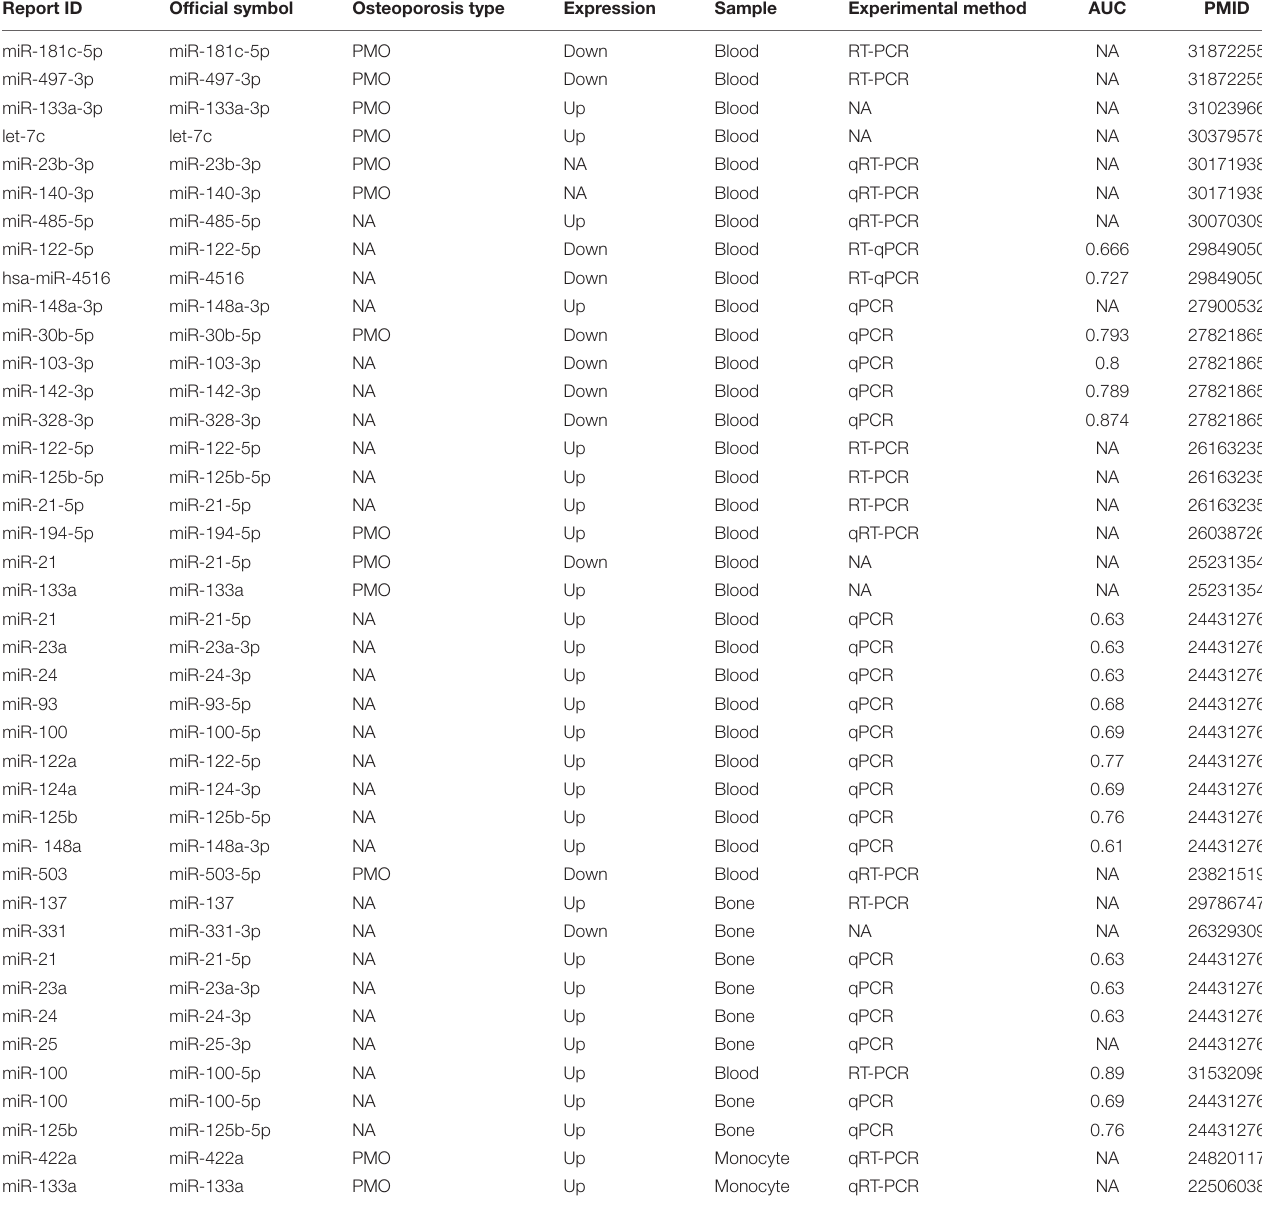
TABLE 1 | Literature-reported osteoporosis miRNAs. Report